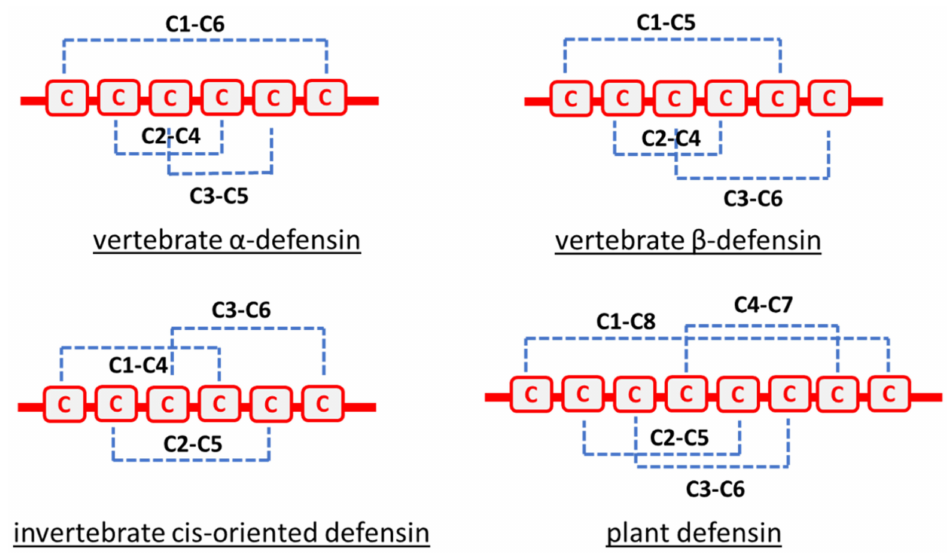
Figure 2. Disulfide bridges’ connectivity pattern characteristic of defensin families: vertebrate